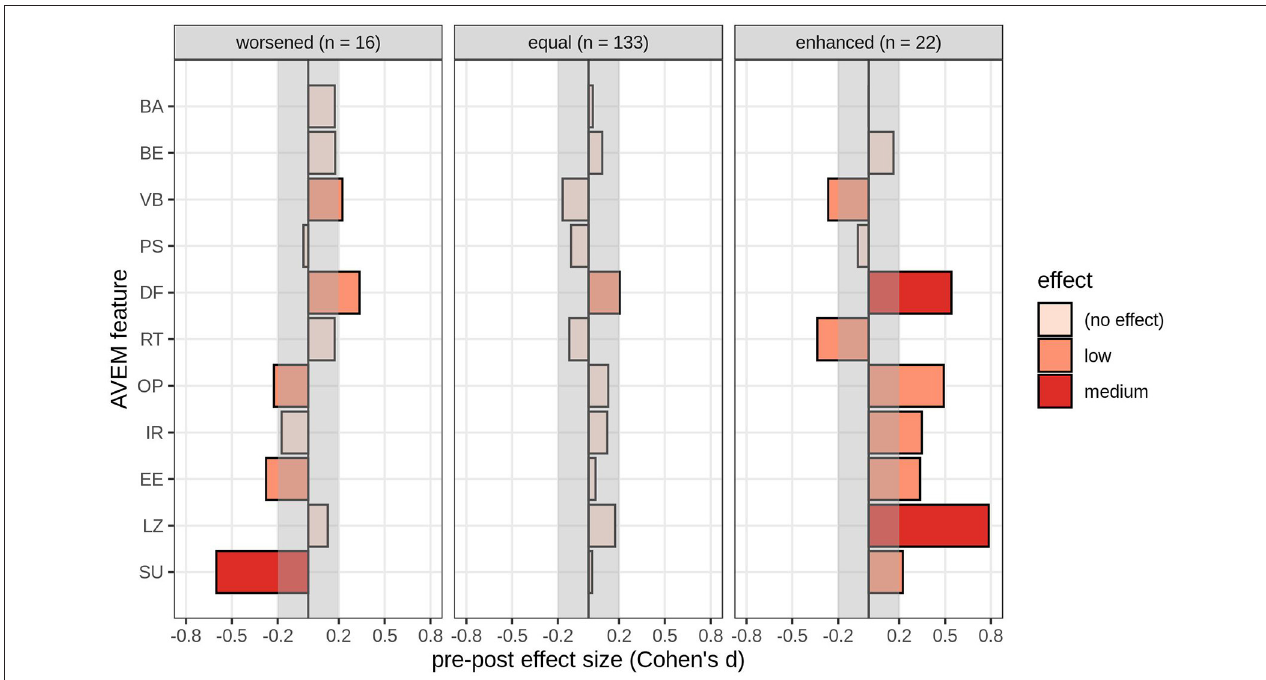
FIGURE 3 | Effect sizes pre- and post-intervention on each AVEM subscale or feature (BA, subjective importance of work; BE, professional ambition; VB, willingness to work to exhaustion; PS, striving for perfection; DF, distancing ability; RT, resignation tendency toward failure; OP, proactive problem-solving; IR, inner calm